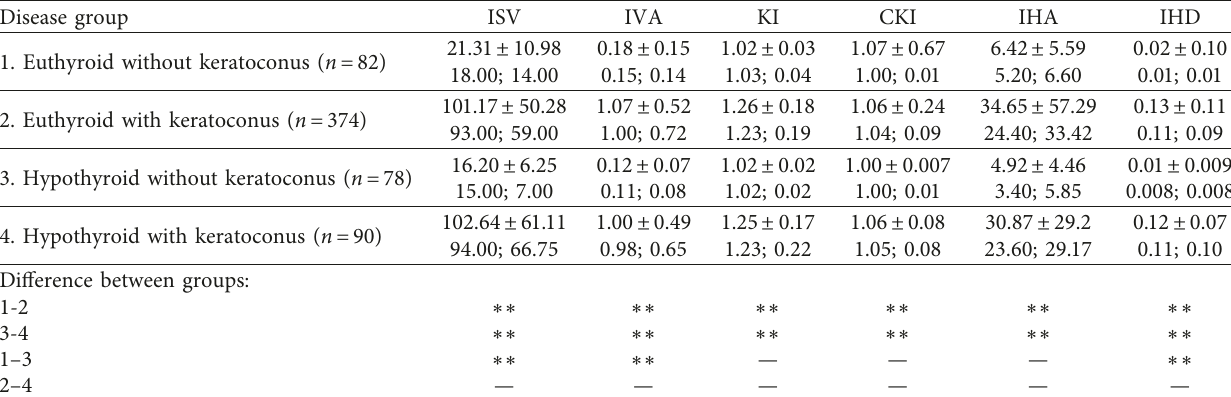
Values represent the mean ± standard deviation or the median; interquartile range, as indicated. a For this group, n � 74; b for this group, n � 340; ∗ p < 0 . 05; ∗∗ p < 0 . 01.SAI:surface asymmetry index;SRI:surface regularityindex;KCI: Klyce/Maeda keratoconusindex; KSI:Smolek/Klyce keratoconus severityindex; KPI: keratoconus prediction index. Table 3: Corneal tomographic parameters measured with the Pentacam in different disease groups. Disease